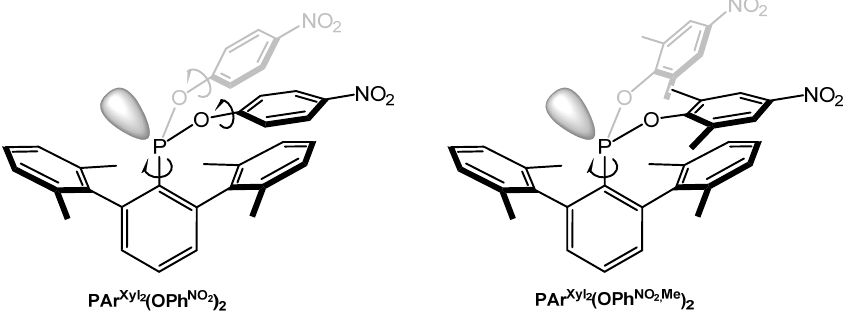
Figure 1. Schematic views of the 3D structures of PAr Xyl 2 (OPh NO 2 ) 2 and PAr Xyl 2 (OPh NO 2 ,Me ) 2 . Curved arrows indicate fast rotations which account for the apparent symmetry observed in NMR experiments.